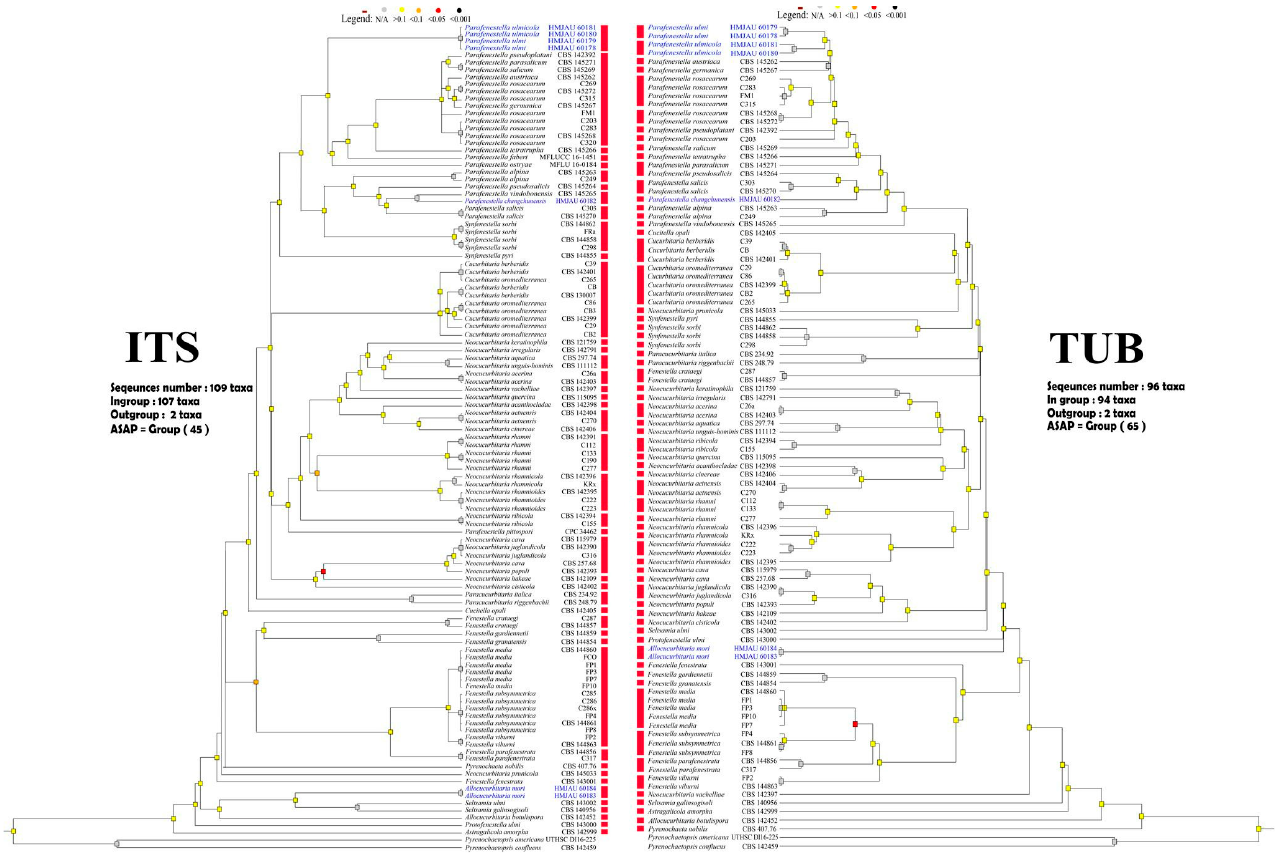
Figure 2. Dendrogram from ASAP analysis based on two datasets (ITS and β -tub markers). The results of species delimitation are indicated by red bars. Sequences generated in this study are in